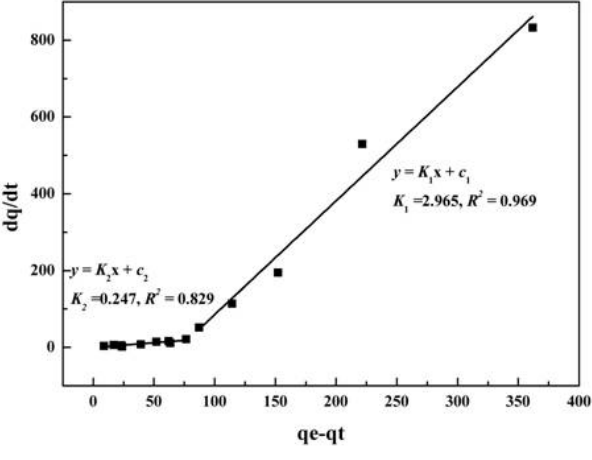
Figure 6. Adsorption rate constants in two-step adsorption kinetic model with 732 resin.